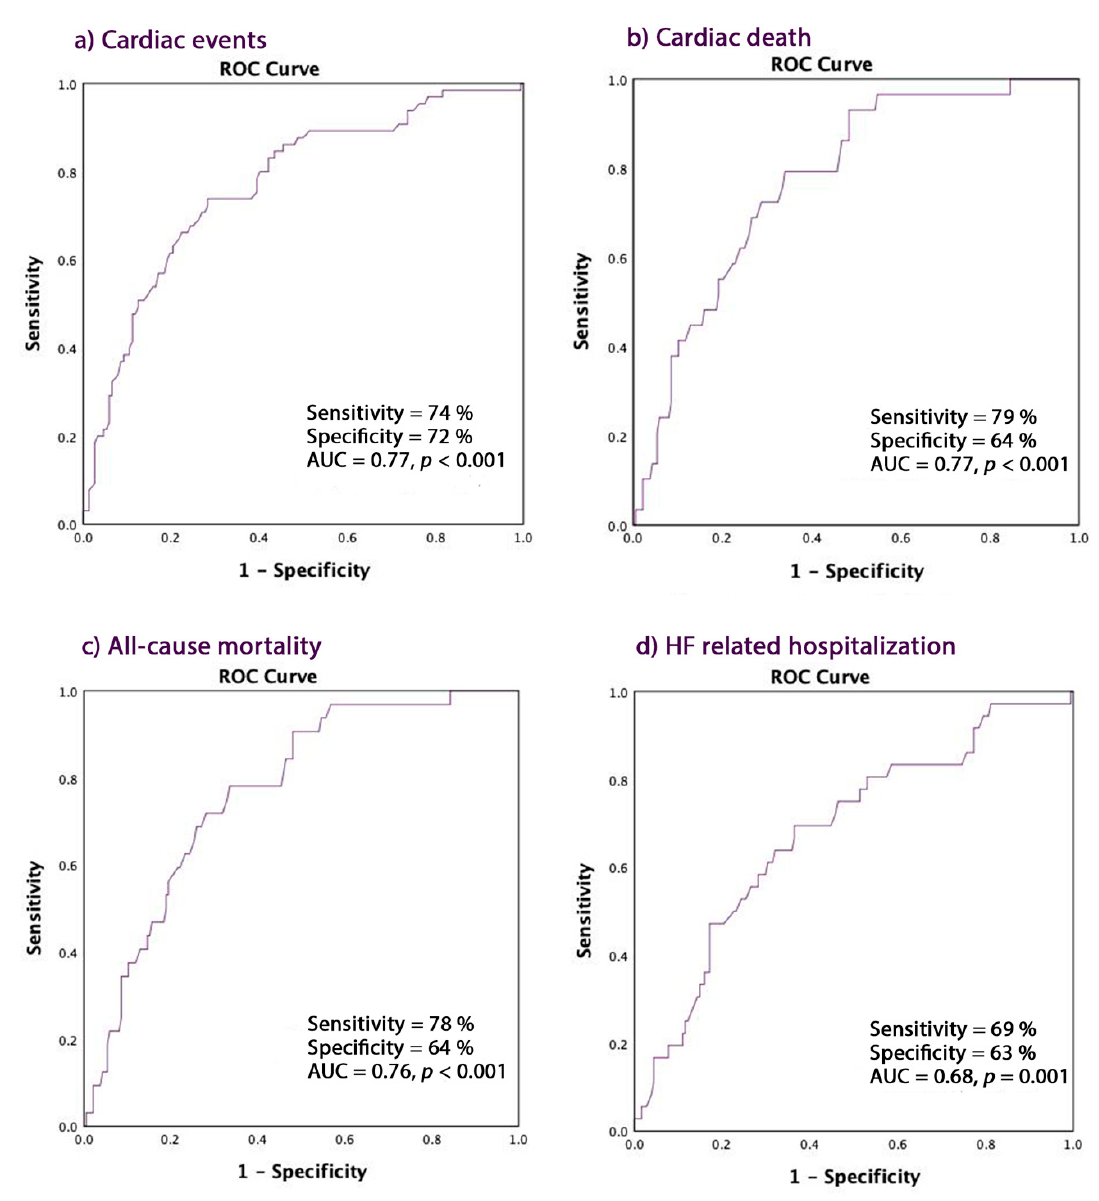
Figure 2. PALS ≤ 16 in predicting. ( a ) Cardiac events; ( b ) Cardiac death; ( c ) All-cause mortality; ( d ) HF-related hospitalization. PALS: peak atrial longitudinal strain .